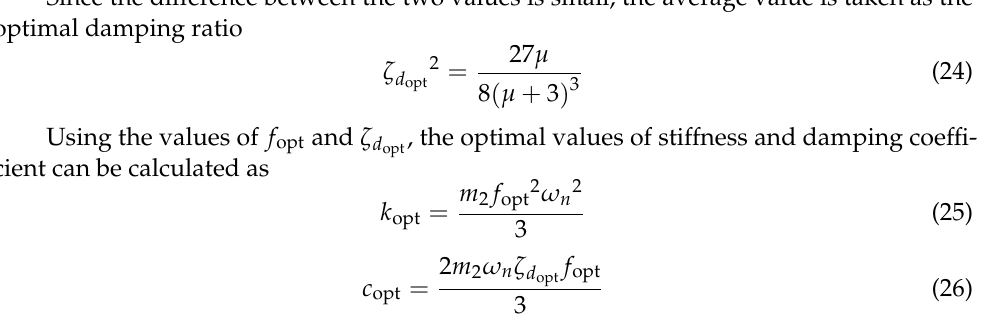
, the optimal values of stiffness and damping coeffi- opt